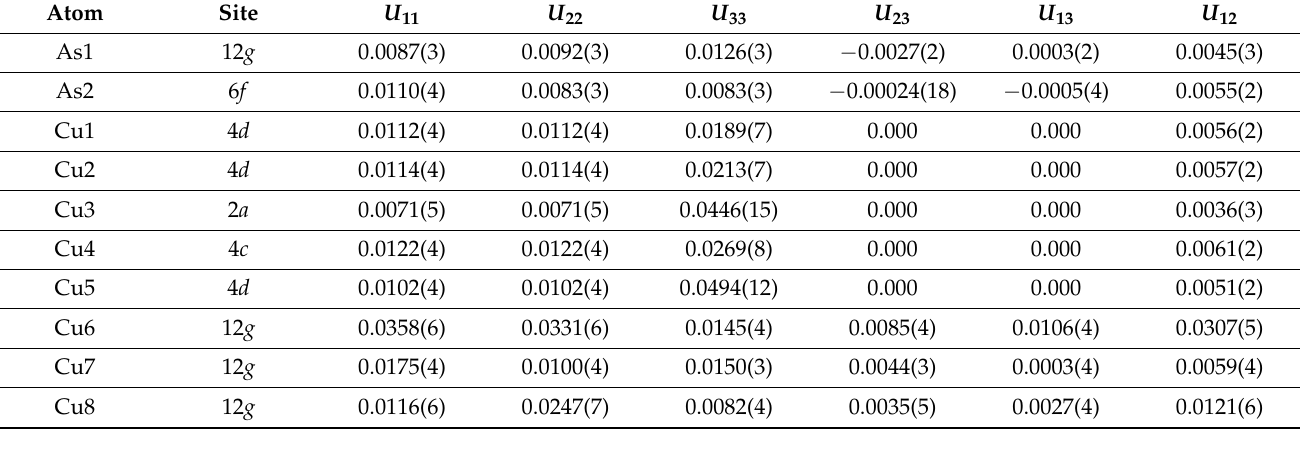
Table 8. Anisotropic displacement parameters for the LT-Cu 2.825(5) As, as obtained from single crystal investigation.